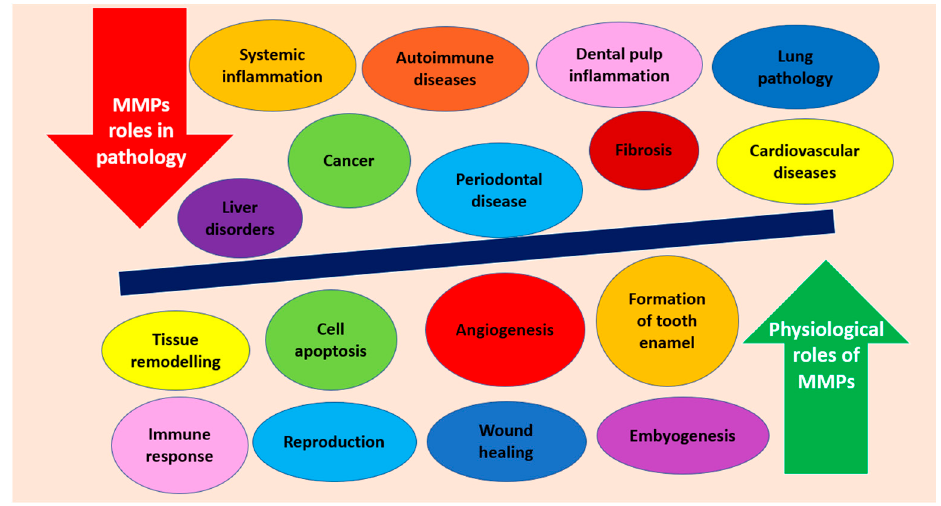
Figure 2. MMPs’ representative roles in physiological and pathological conditions.